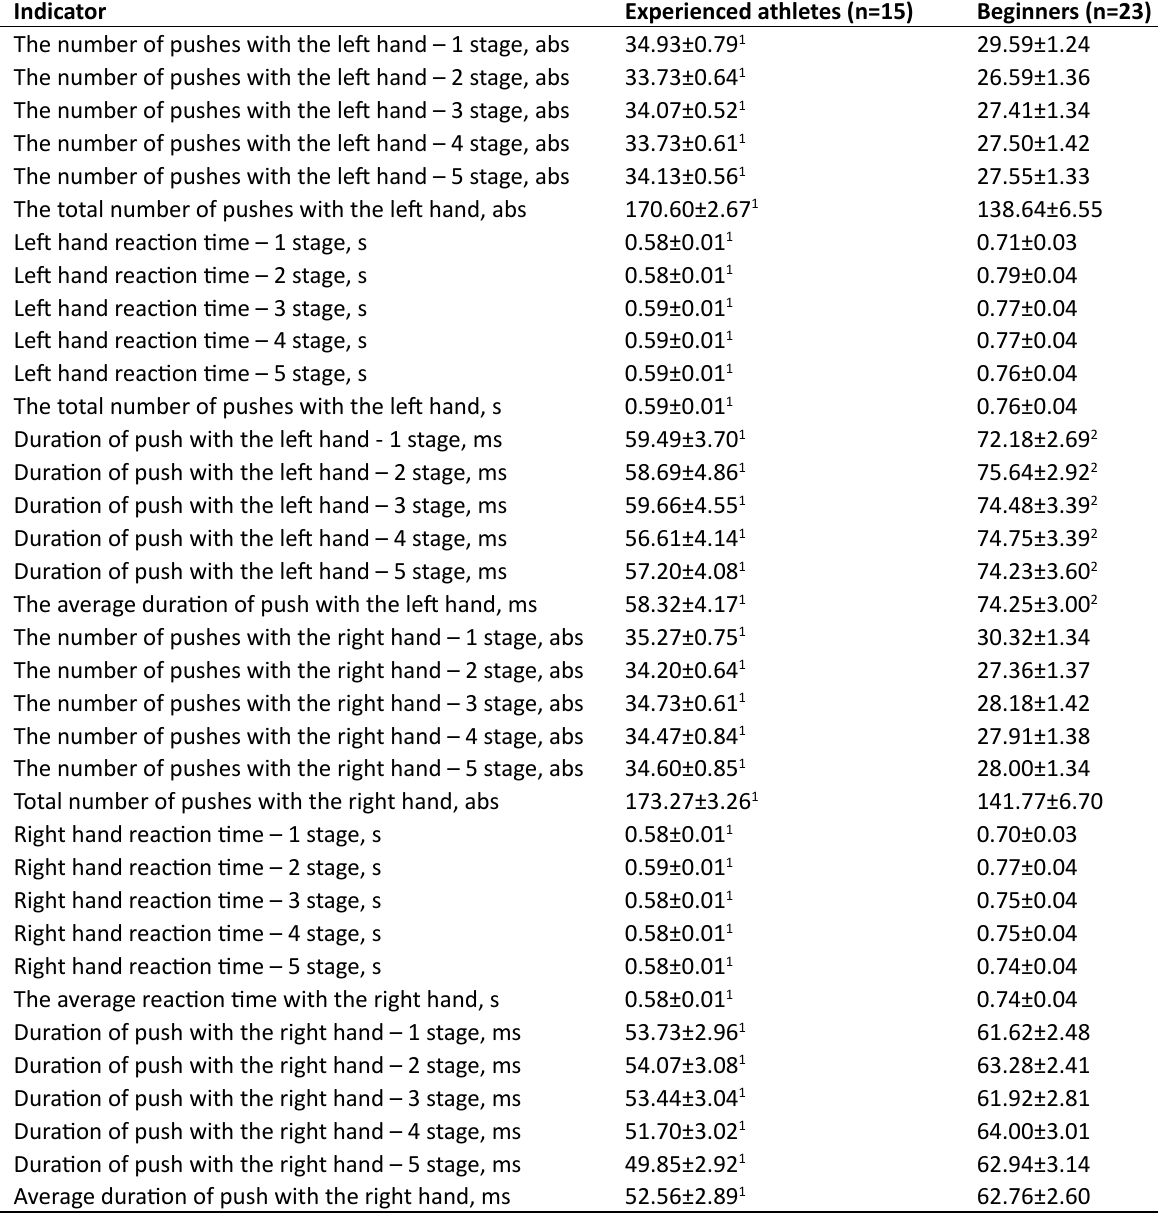
Table 2. The differentiated test performance of functional asymmetry by athletes with different skills’ levels